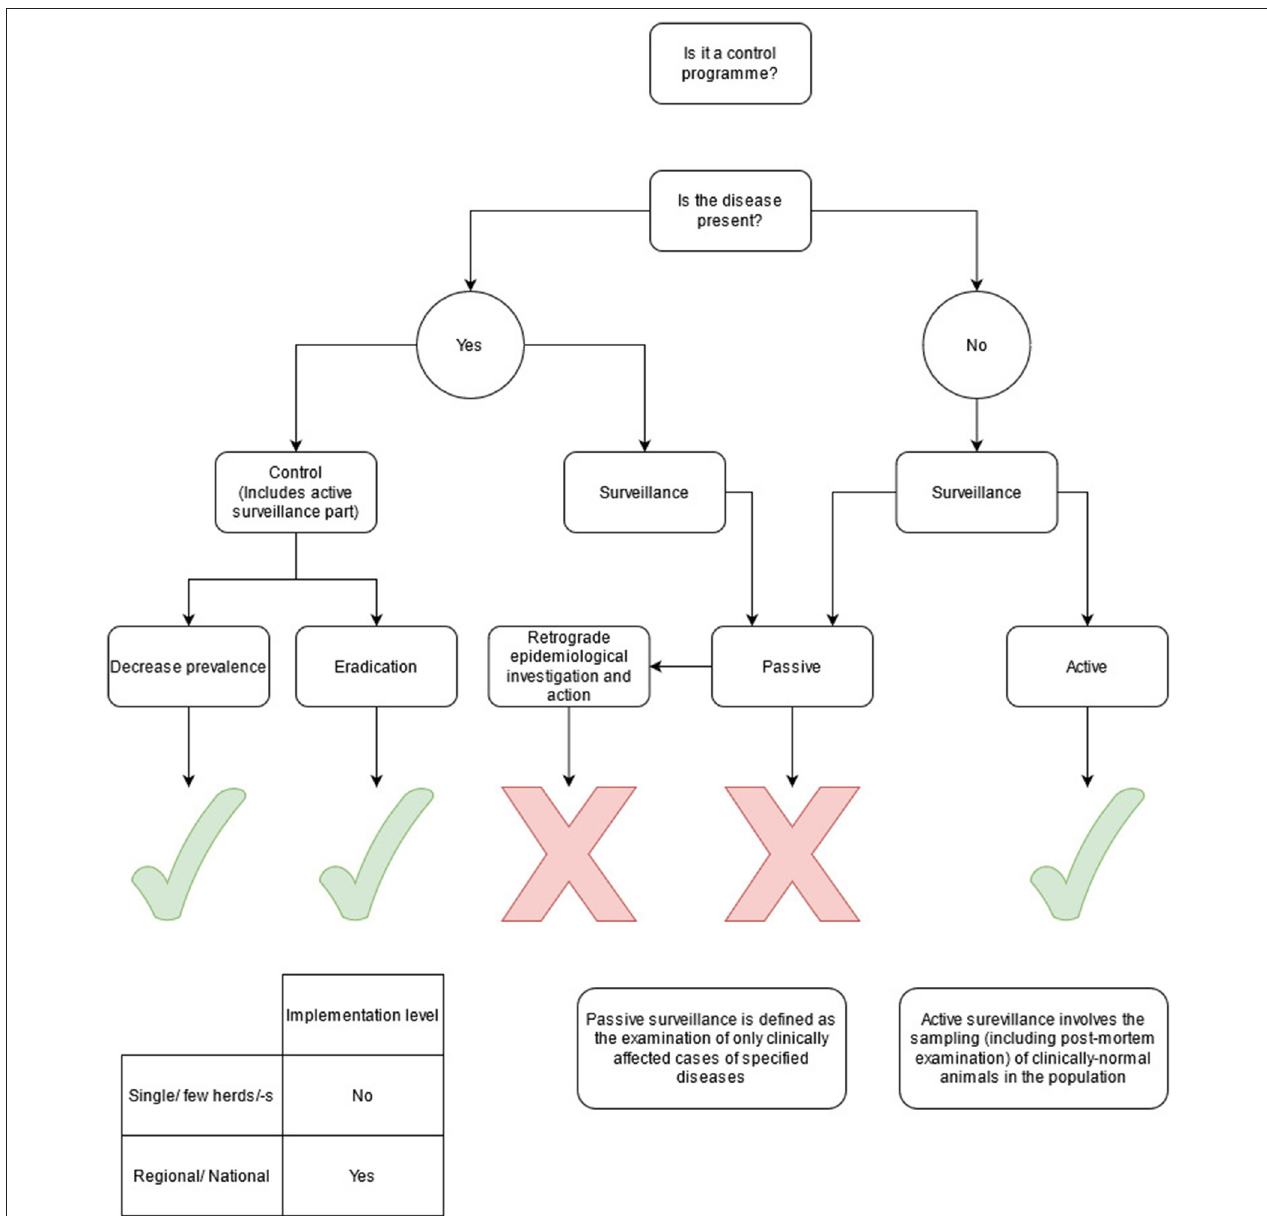
FIGURE 1 | Flowchart giving inclusion and exclusion criteria for control programmes included in the survey.